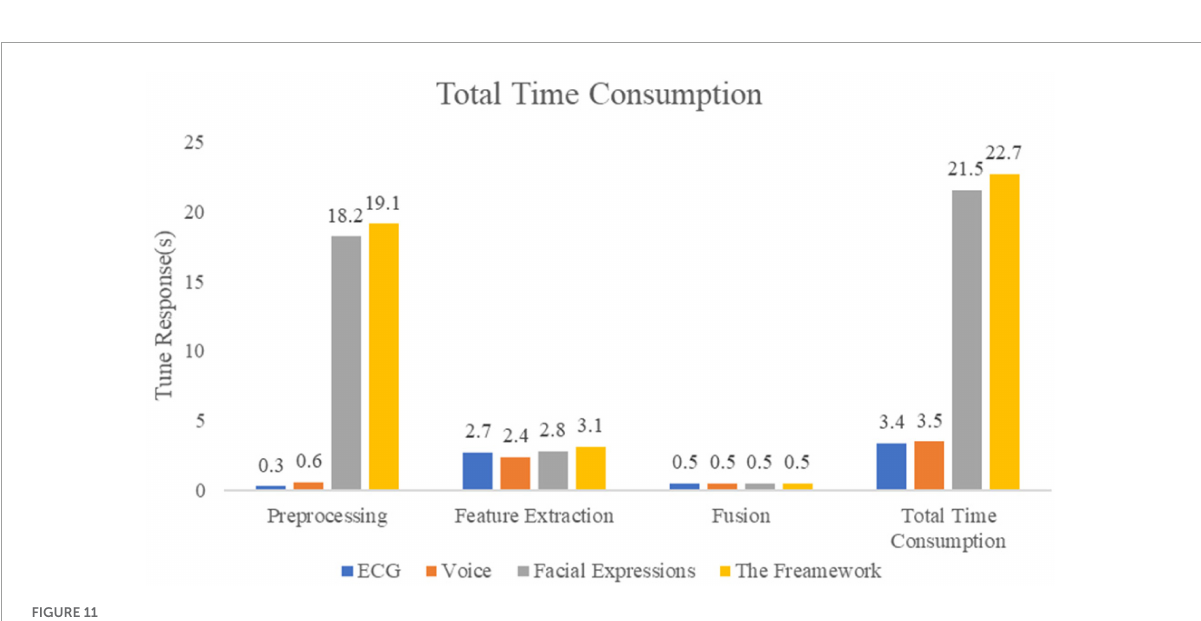
FIGURE11 Time assessment for real-time